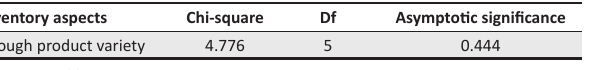
TABLE 15: Kruskal–Wallis test results on Hypothesis 5.